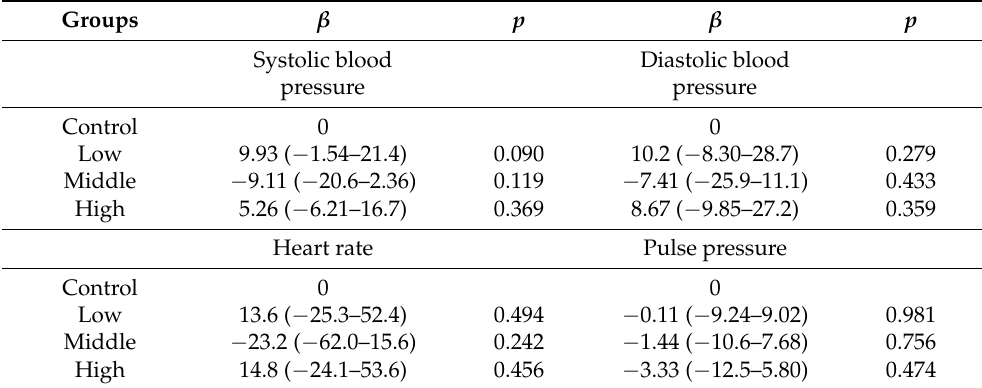
Table 3. Dose–response analysis between the administration levels of 14 REEs to rats and blood